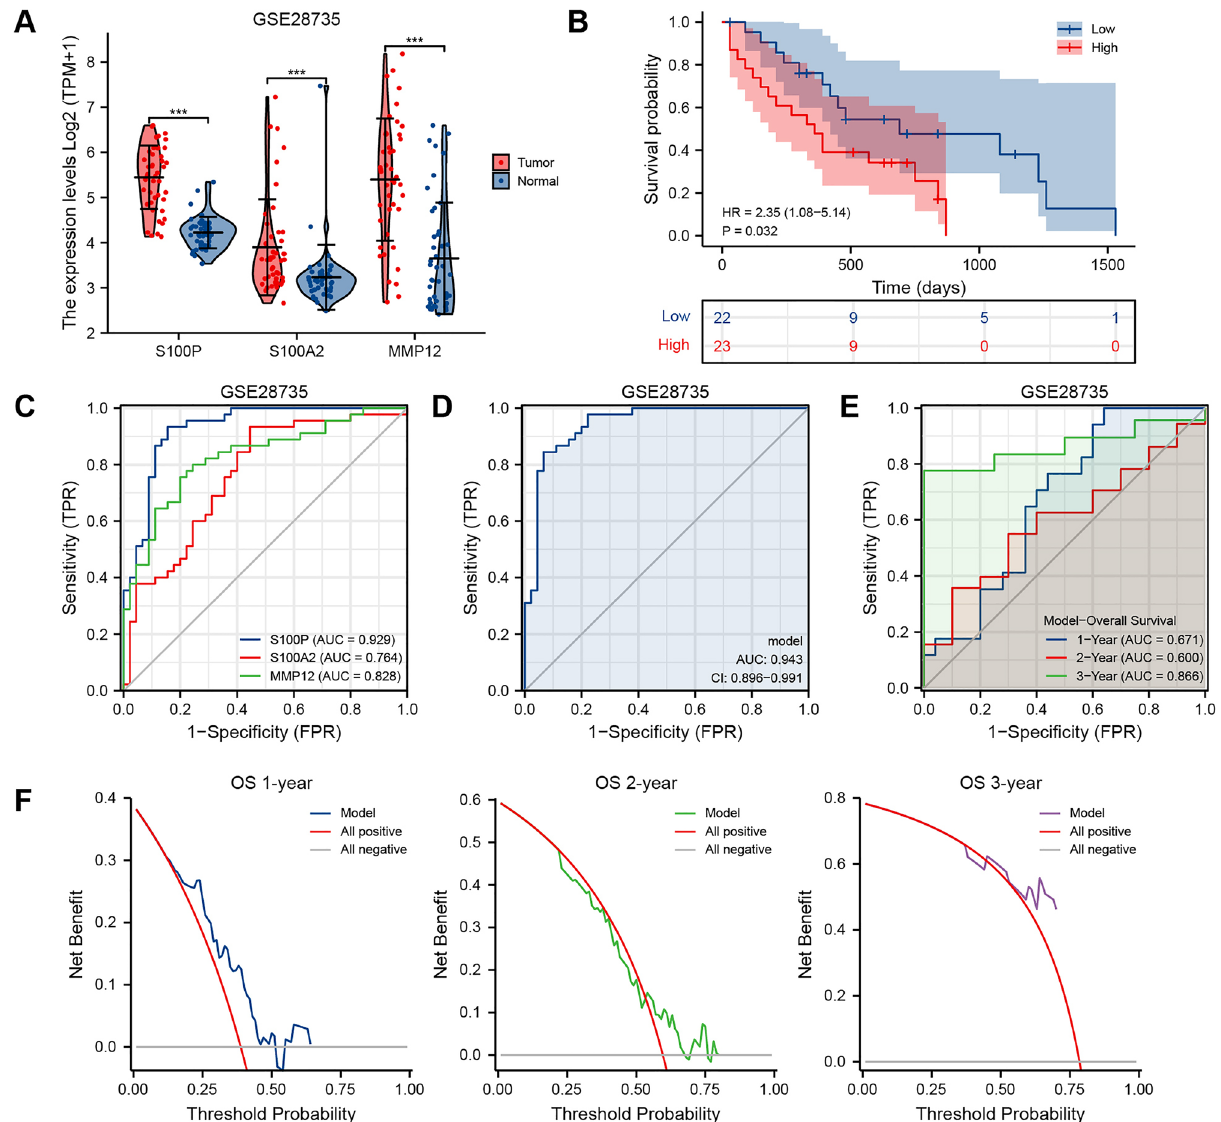
Figure 6. Validation of PAAD-IRGS with GSE28735. ( A ) Expression level of 3 IRGs in GSE28735 cohort; ( B ) Kaplan–Meier curves show a better OS in the low-risk group than the high-risk group; ( C ) diagnostic value of 3 IRGs for PAAD patients in GSE28735 cohort; ( D ) diagnostic value of PAAD-IRGS in GSE28735 cohort; ( E ) time-dependent ROC curve analysis of the PAAD-IRGS at 1, 2, and 3 years in GSE28735 cohort; ( F ) decision curve analysis for evaluating the net benefits of PAAD-IRGS in GSE28735 cohort. * P < 0.05, ** P < 0.01, *** P <